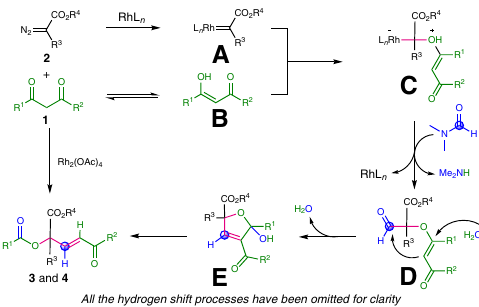
Fig. 5 Plausible reaction mechanism. A plausible mechanism involves the carbene insertion reaction of intermediates A , B to afford oxonium ylide C , subsequent nucleophilic addition, intramolecular aldol reaction, and retro- Baylis − Hillman-type reaction to form the desired products 3 and